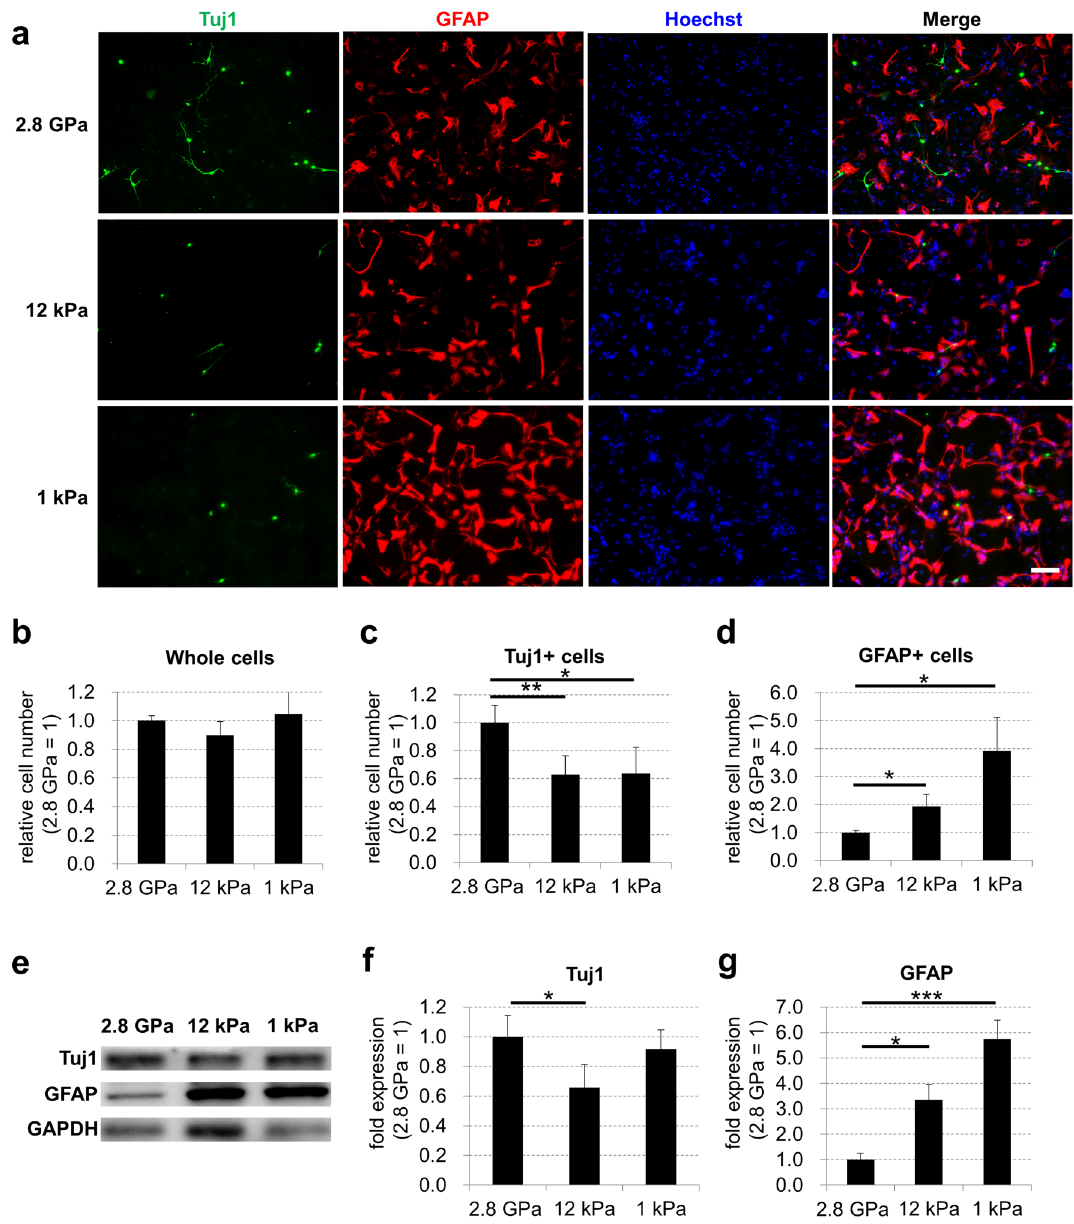
Figure 1. Soft surfaces increase astrocytes differentiated from mouse embryonic neural stem cells in the absence of serum. ( a ) Mouse embryonic NSCs were cultured on three types of plate (1 kPa plates, 12 kPa plates, and commonly used plastic plates [2.8 GPa]) for 3 days in serum-free condition and assessed by immunofluorescence staining. Neurons were visualized by Tuj1 (green), astrocytes were visualized by GFAP (red), and cell nuclei were counterstained with Hoechst (blue). Scale bar, 100 μm. ( b ) Whole cell number, ( c ) the number of Tuj1 positive cells, and ( d ) the number of GFAP positive cells on each plate were counted and normalized relative to the control. ( e ) Protein expression of Tuj1, GFAP, and GAPDH (for loading control) on each plate was detected by western blotting analysis. The expression levels of ( f ) Tuj1 and ( g ) GFAP proteins were normalized relative to GAPDH protein. Error bars represent the standard deviation; * p < 0.05, ** p < 0.01, *** p < 0.005 (Student’s t test with Bonferroni correction). NSCs neural stem cells, GFAP glial fibrillary acidic protein, GAPDH glyceraldehyde 3-phosphate Differentiation of astrocytes from embryonic NSCs on stiff surfaces is increased by treat- ment with a ROCK inhibitor in the absence of serum. To determine whether PP-MRLC regulates the differentiation of embryonic NSCs, we treated NSCs with the ROCK inhibitor Y27632 and analyzed the differentiation of the cells into neurons or astrocytes. We cultured mouse embryonic NSCs for 3 days with or without 10 μM Y27632 on plastic plates in serum-free conditions and compared the expression of Tuj1 and GFAP. Immunostaining showed that the whole cell number was not significantly different between the cells; on